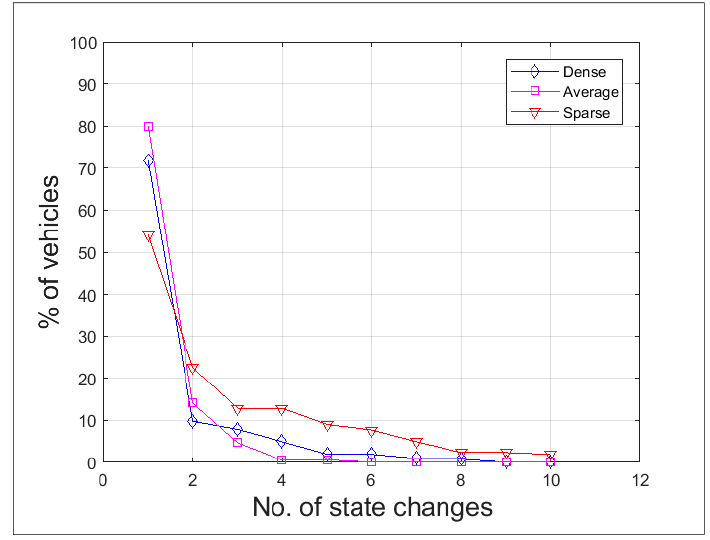
Figure 10. Cluster Figure 10. Cluster stability.